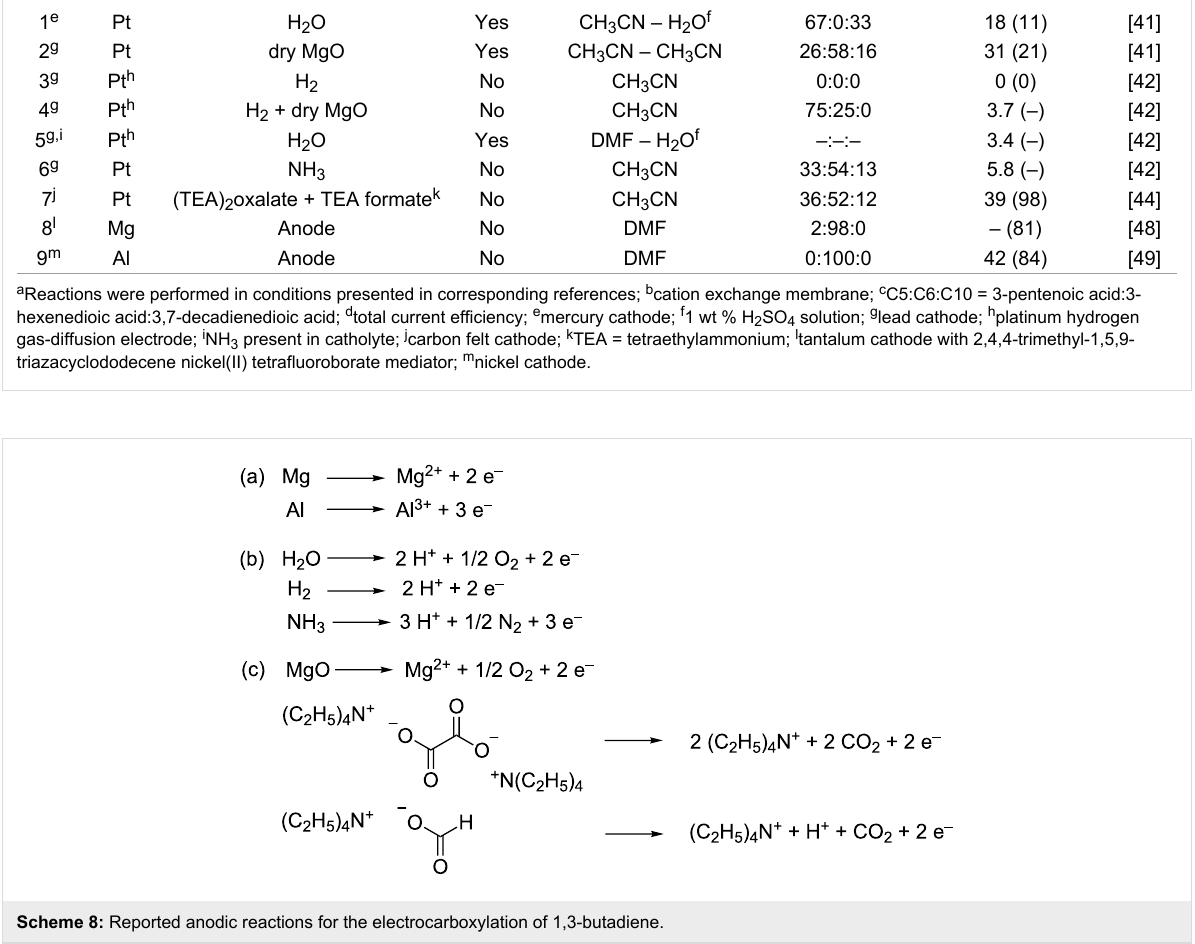
Entry Anode Reducing agent CEM b